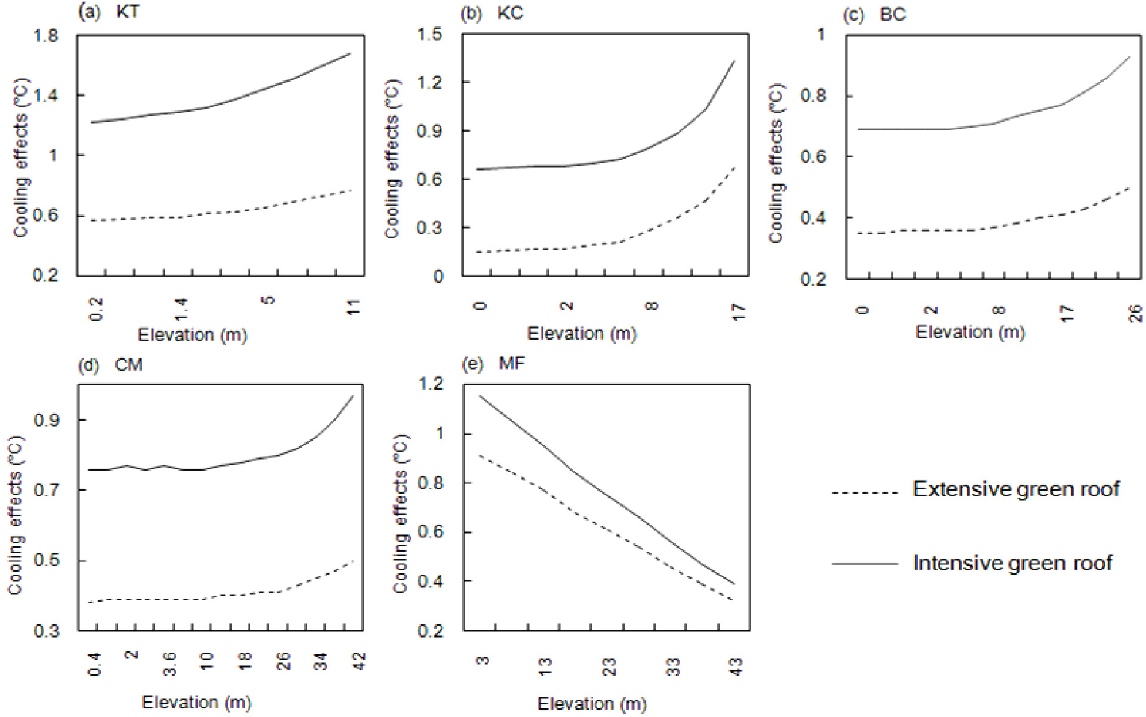
Figure 9. Vertical distribution of cooling effects for EGR and IGR; the y-axis shows the magnitude of temperature